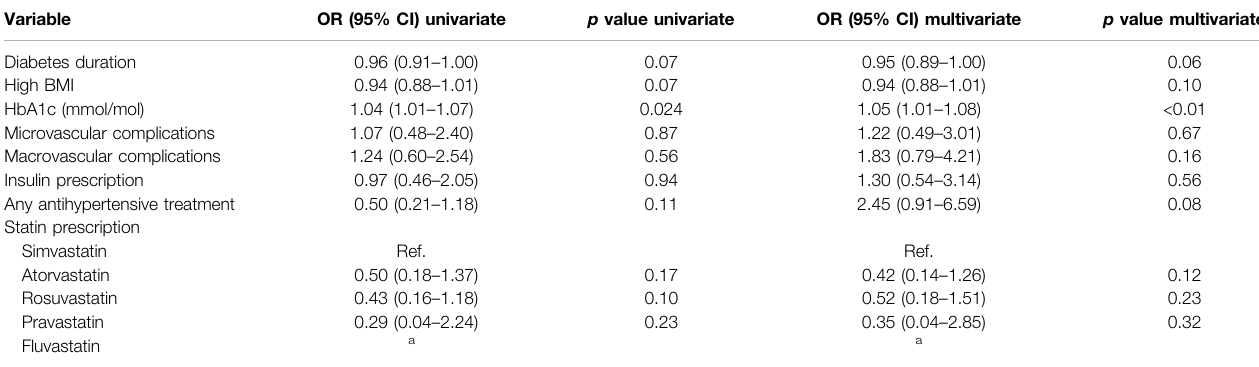
TABLE 3 | Independent determinants of nonadherence to statins. Variable